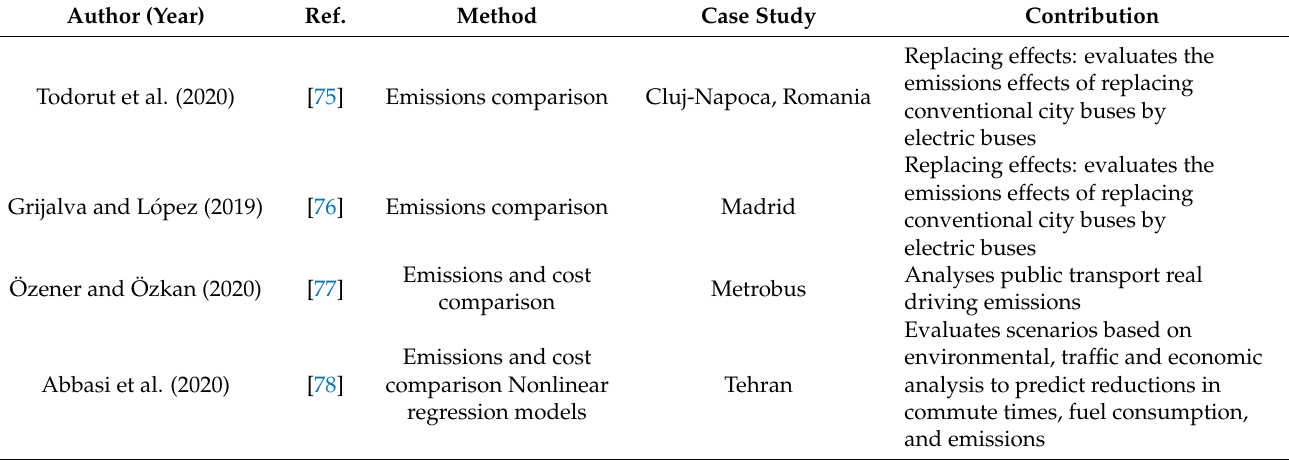
Table 4. Literature review on bus assessment based on fuel consumption and